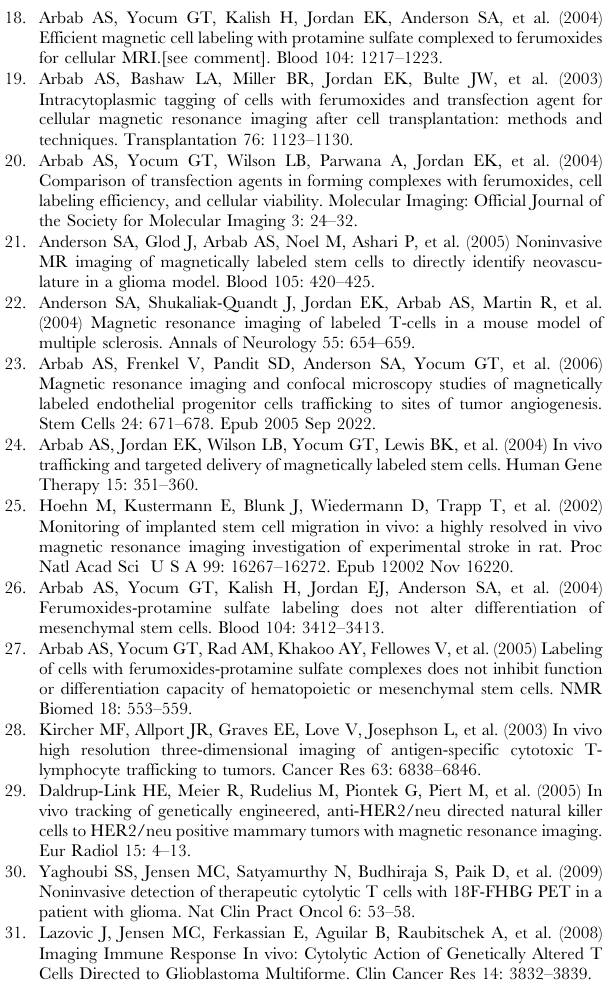
the small tumor. Figure S5A: T2WI shows high signal intensity areas (arrows) at the site that are considered to be the growing tumor at day 10 (A) and day 14 (B) following the implantation of tumor (day 3 and 7 after IV administration of labeled CTLs). Note the extension of tumor along and below the corpus callosum. T2*WI shows low signal intensity at the sites thought to be growing tumor (arrows) at day 3 (C) and day 7 (D) after the administration of labeled CTLs. Note the low signal areas that are indeed within the high signal areas seen on T2WI. The low signal area seen in the cortex (thick arrow) might be due to needle track and hemorrhage during implantation of tumor. Figure S5B: DAB enhanced Prussian blue (A, B) and CD45RO (C) staining from consecutive sections showing the accumulated iron positive cells (dark brown) in the small tumor mass (A, 10x) and (B, 40X). CD45RO staining shows multiple activated T-cells within the tumor (arrows, Magnification 40X). Found at: doi:10.1371/journal.pone.0009365.s006 (9.53 MB